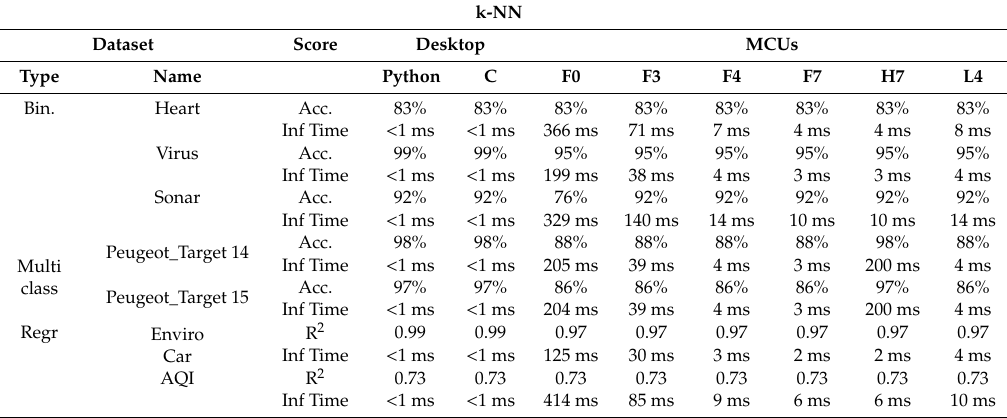
Table 10. k-Nearest Neighbors (k-NN)